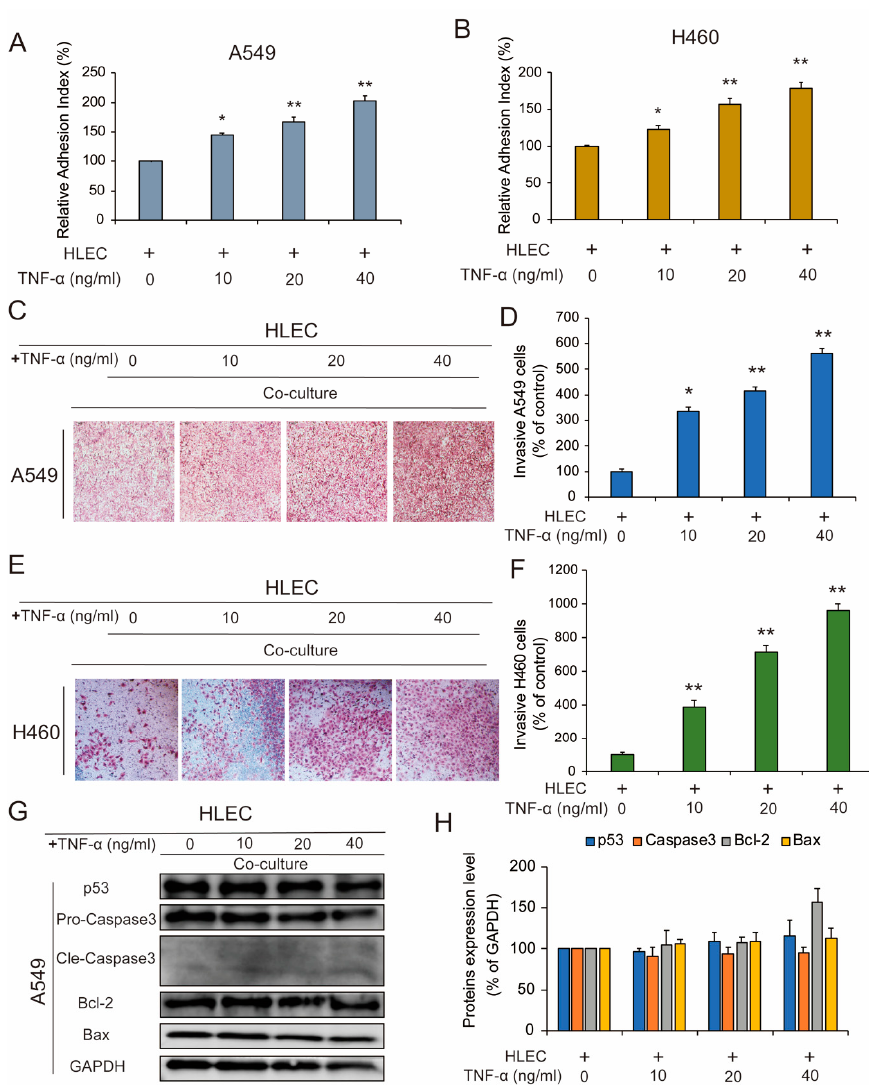
Figure 4. Co-culture of HLEC and A549 cells promoted the lymphatic metastasis of CCR7-overexpressed NSCLC cells. HLEC were exposed to different concentrations of TNF- α (10, 20, and 40 ng / mL) for 48 h. Then the TNF- α was removed and replaced with fresh medium to continue culturing for 48 h. Next, A549 or H460 cells were co-cultured with the above HLEC for 48 h. ( A,B ) A549 cells or H460 cells were collected and 100 μ L cell suspension (2 × 10 5 cells/mL) was added to the 96 wells which are pre-coated with matrigel. After incubating for 1 h, adherent cells were determined by MTT assay. Data represent the mean ± S.E.M. from three independent experiments. Asterisks denote statistically significant (* p < 0.05 and ** p < 0.01) differences compared with controls by one-way ANOVA. ( C,D ) The invasive ability of A549 cells was evaluated by a matrigel-coated transwell invasion assay (image magnification: 200×). Each experiment was performed at least three times. Data are presented as mean ± S.D. * p < 0.05 compared with the control group; ** p < 0.01 compared with the control group. ( E,F ) The invasive ability of H460 cells was evaluated by a matrigel-coated transwell invasion assay (image magnification: 200 × ). Each experiment was performed at least three times. Data are presented as means ± S.D. * p < 0.05 compared with the control group; ** p < 0.01 compared with the control group. ( G,H ) Changes in the expression of some cellular apoptosis controlling proteins (p53, Caspase-3, Bcl-2 and Bax) in A549 cells following co-culture with TNF- α (10, 20, and 40 ng / mL)-pretreated HLEC. Western blotting was performed to detect expression changes of the listed proteins, using glyceraldehyde-3-phosphate dehydrogenase (GAPDH) as loading controls. Data represent the mean ± S.E.M. from three independent